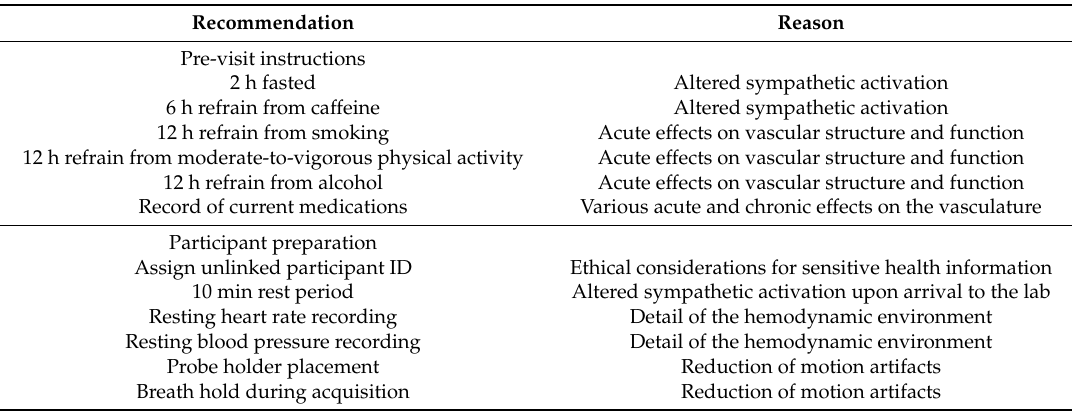
Table 2. Methodological considerations in cardiovascular human